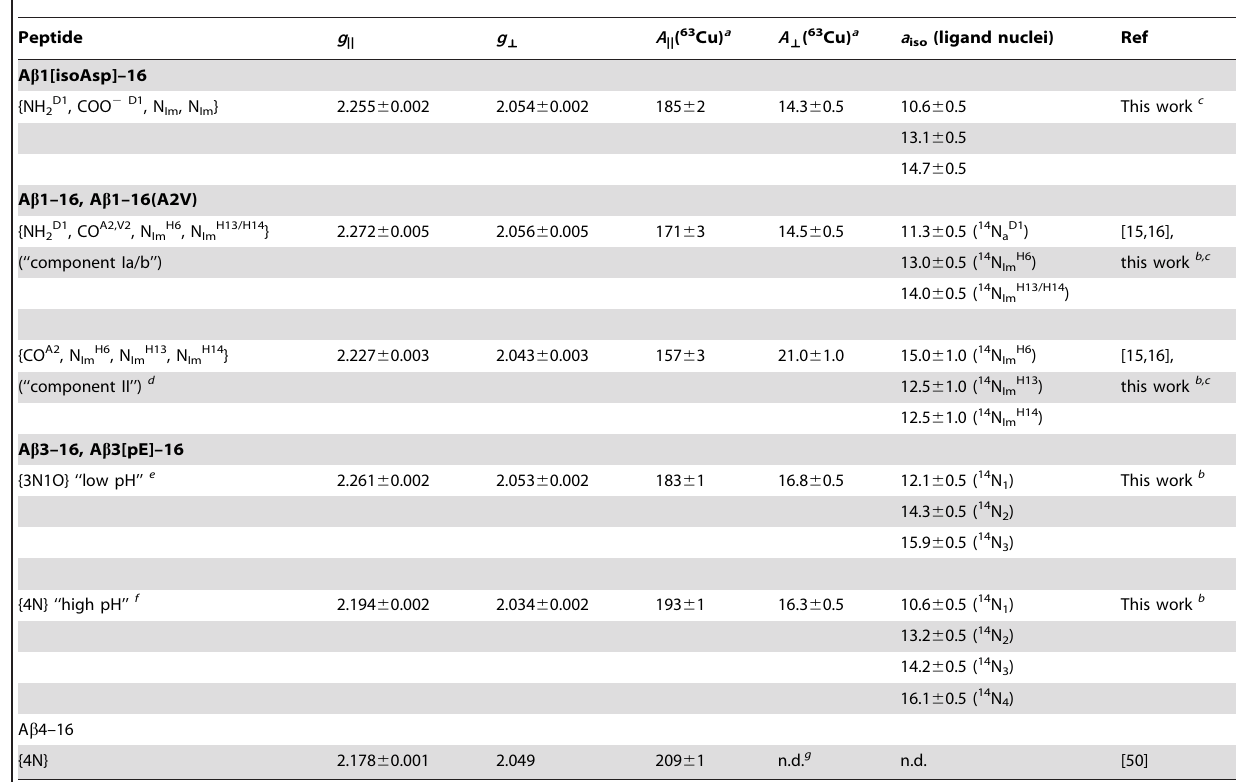
Peptide g || g H A || ( 63 Cu) a A H ( 63 Cu) a